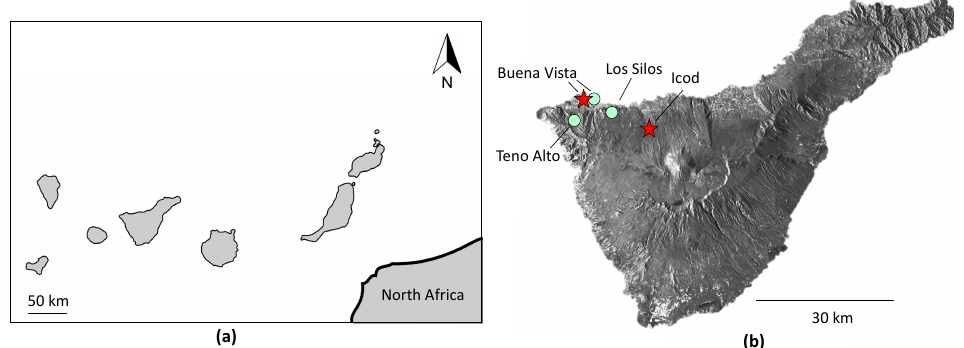
Figure 1. Maps of ( a ) the Canary Islands and ( b ) Tenerife. Fossil localities are indicated with red stars, and plant collection localities are indicated with green circles. The regional map is from Wikimedia Commons [78] ; modified Tenerife base map is from Airbus Defence and Space [79] .